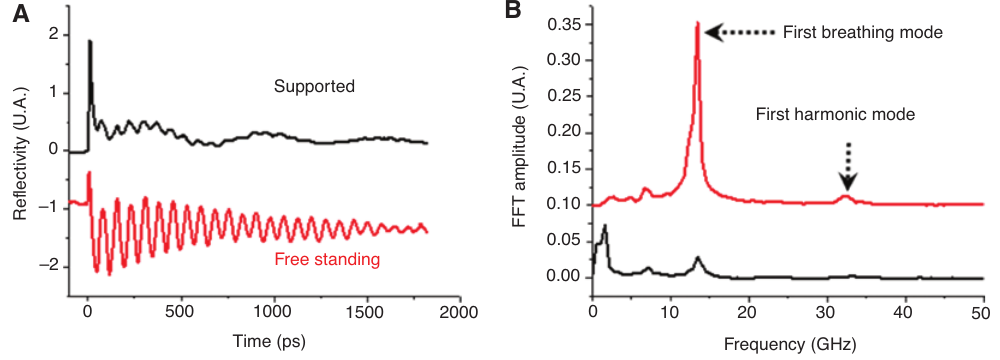
Figure 21: Phonons in supported and free standing single nanowire. (A) Comparison of transient reflexivity of a single Au40% – Ag60% supported or in free standing geometry. (B) Fast Fourier transform exhibiting different vibrational responses. The signature of the fundamental breathing mode is larger and the first harmonic (32.2 GHz) is clearly visible in the suspended area while the contact mode is only visible where the nanowire is in interaction with the substrate.